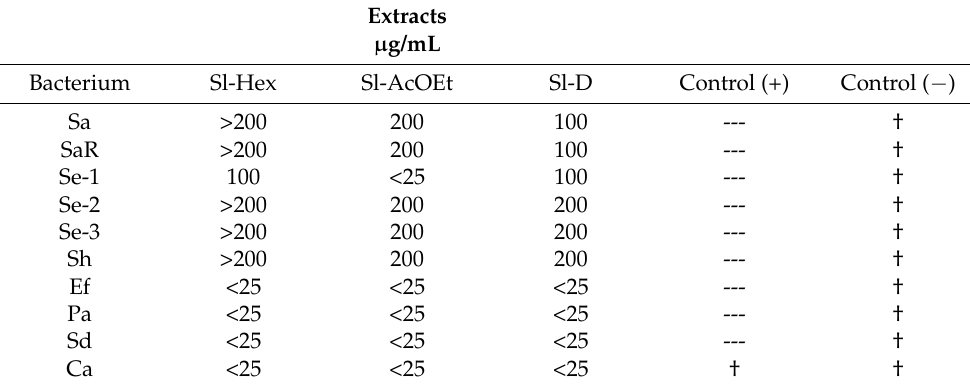
Table 3. Antimicrobial activity of Salvia lavanduloides